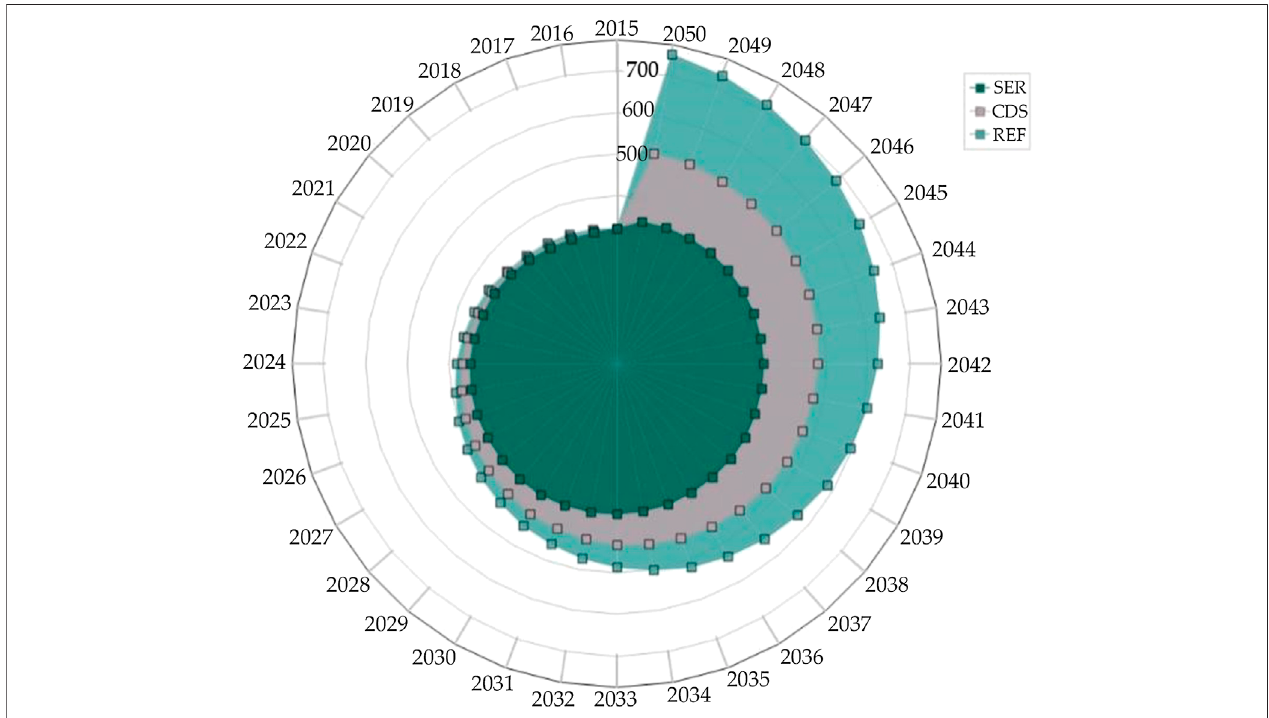
FIGURE 3 | The energy demand in the three scenarios during the period 2015 – 2050.